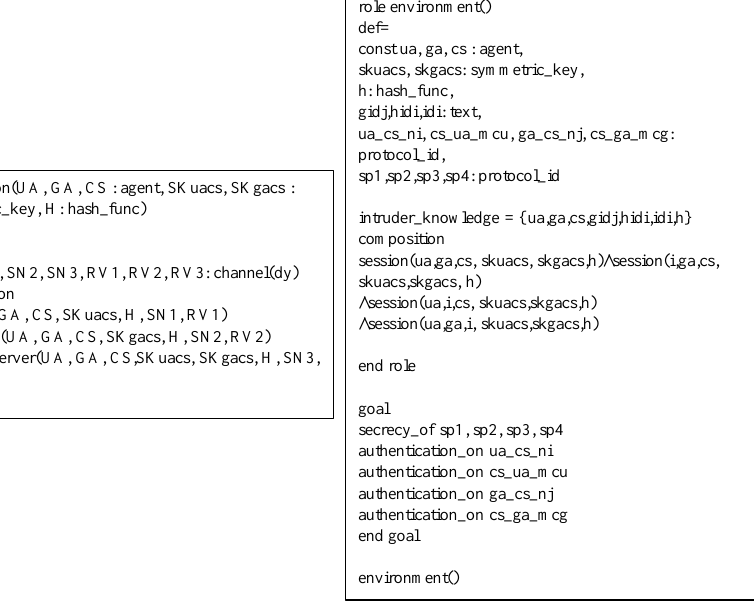
Figure 8. Specification of session and